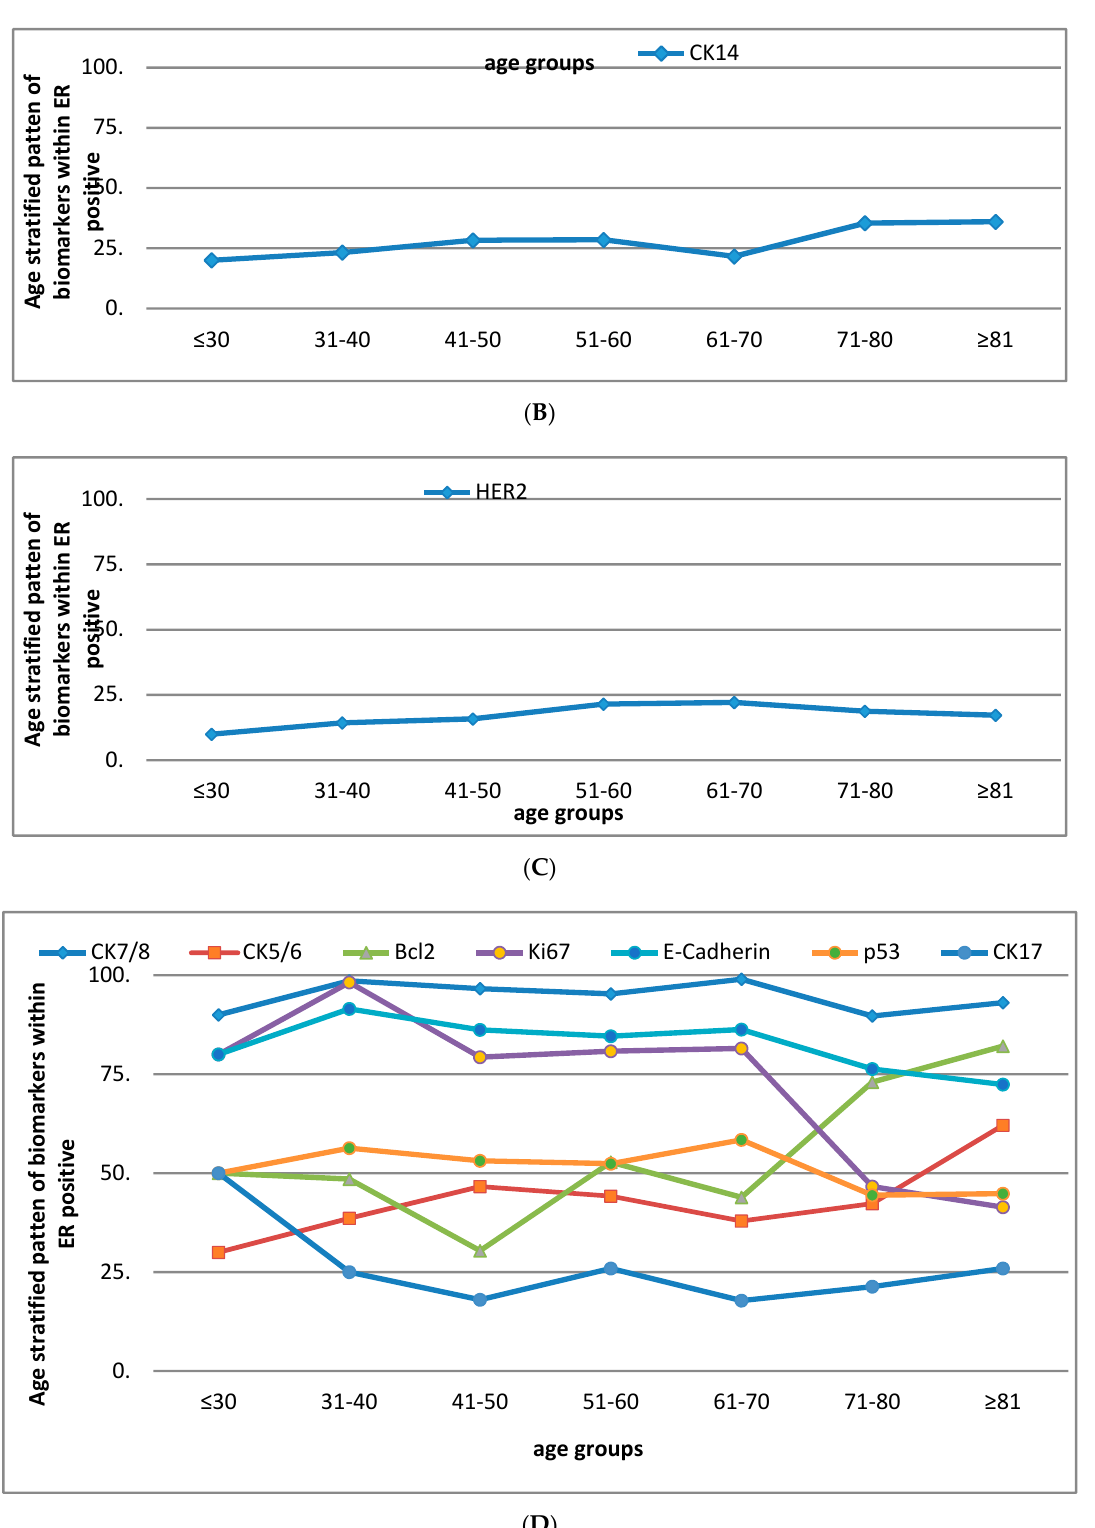
Figure 3. ( A ) Pattern of the expression of biomarkers with age stratification in ER negative early operable primary breast cancer treated by surgery—gradual rise. ( B ) Pattern of the expression of biomarkers with age stratification in ER negative early operable primary breast cancer treated by surgery—rise at 70 years. ( C ) Pattern of the expression of biomarkers with age stratification in ER negative early operable primary breast cancer treated by surgery—decline at 70. ( D ) Pattern of the expression of biomarkers with age stratification in ER negative early operable primary breast cancer treated by surgery— two